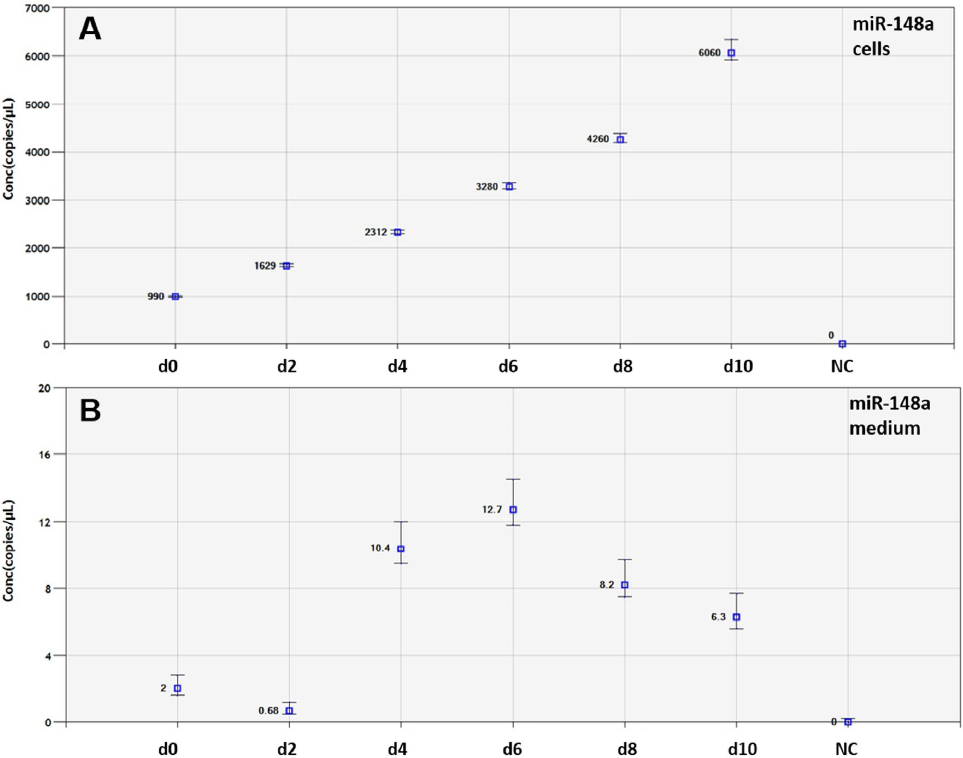
Figure 3. Examples of the detection of miRNAs using the ddPCR method. Absolute quantification (concentration in copies/ µ L) of miR-148a in cells ( A ) and cell culture medium ( B ) at days 0 (d0), 2 (d2), 4 (d4), 6 (d6), 8 (d8), and 10 (d10). NC: negative control (sample without cDNA template). Error bars indicate the Poisson 95% confidence intervals.